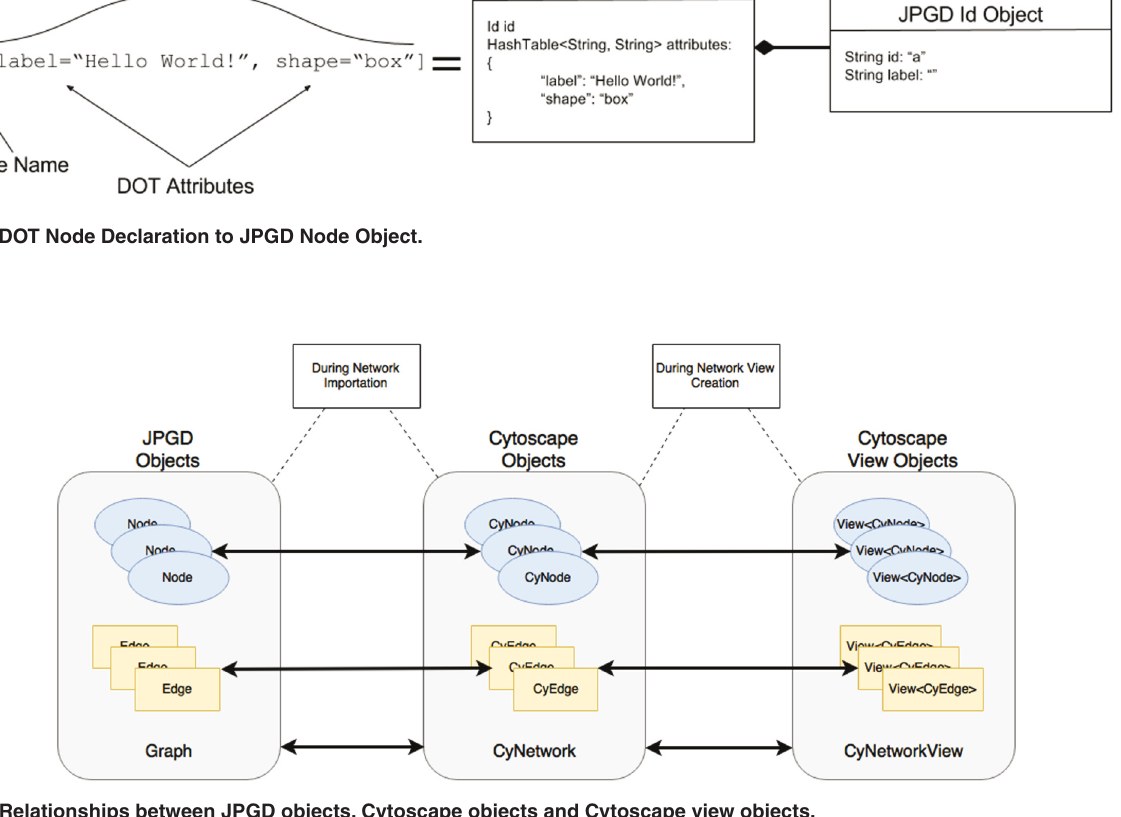
Figure 9. Relationships between JPGD objects, Cytoscape objects and Cytoscape view